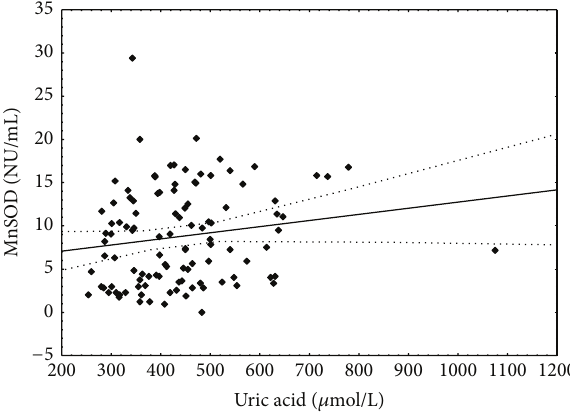
Figure 5: Correlation between uric acid concentration and man-